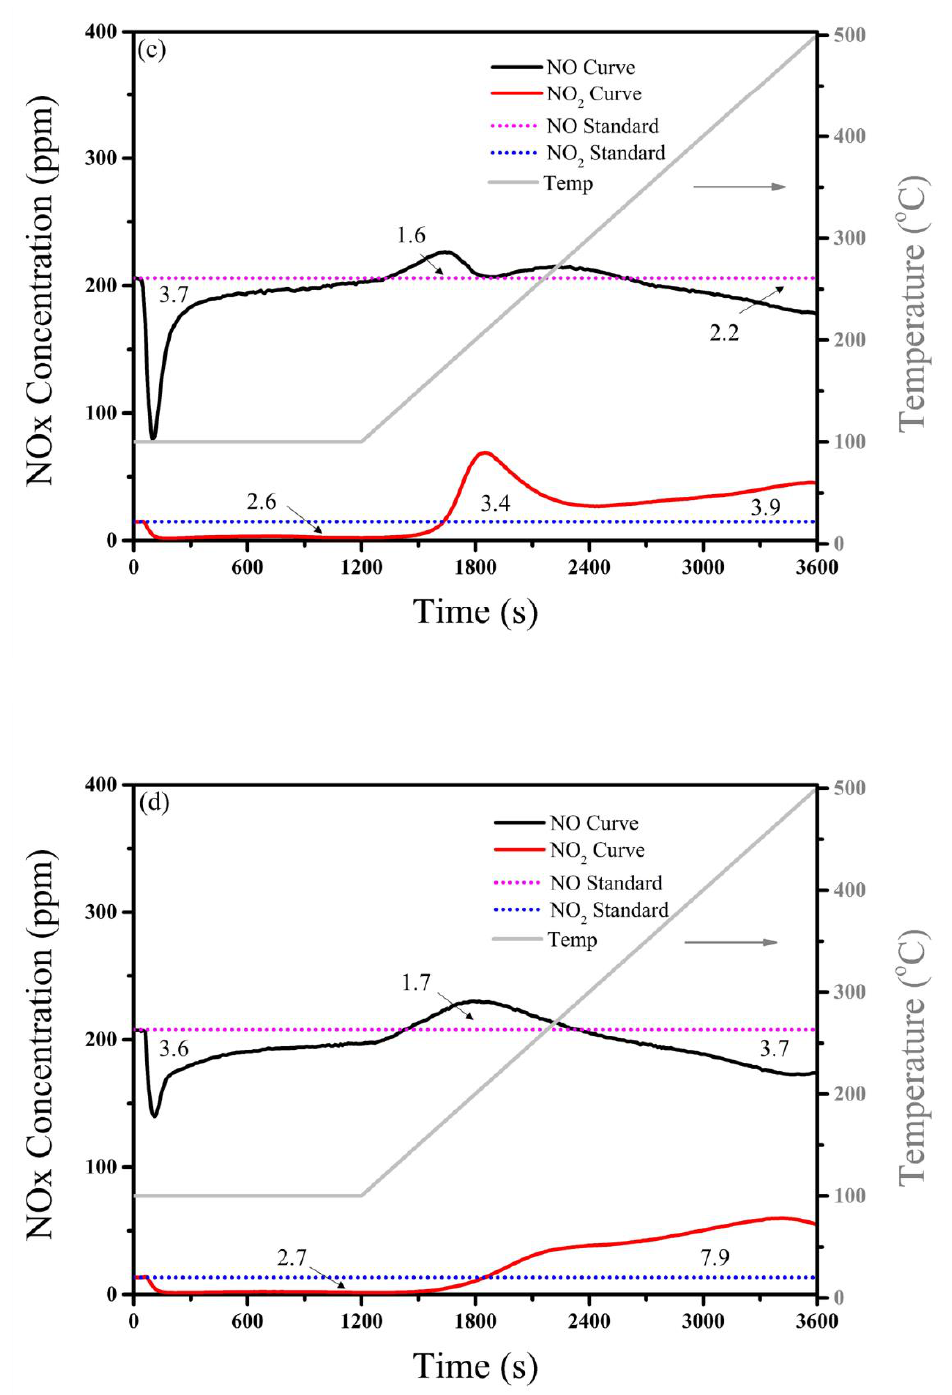
Figure 5. Transient NO x adsorption at 100 ◦ C and temperature programmed desorption of ( a ) Pd/SSZ-13 and K-deactivated samples ( b ) 0.5K-Pd/SSZ-13, ( c ) 1.0K-Pd/SSZ-13 and ( d ) 1.5K-Pd/SSZ-13. To better simulate the actual after-treatment condition, 5% H 2 O was added to the feed gas to evaluate the water tolerance of as-prepared Pd/SSZ-13, and the PNA perfor- mance is displayed in Figure 6. Compared to the adsorption ability of fresh Pd/SSZ-13,